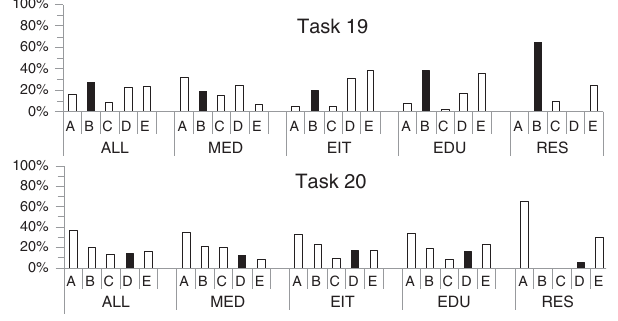
FIG. 9. The students ’ responses to the tasks grouped by the gas entropy concept concerned. For a detailed description see Fig.